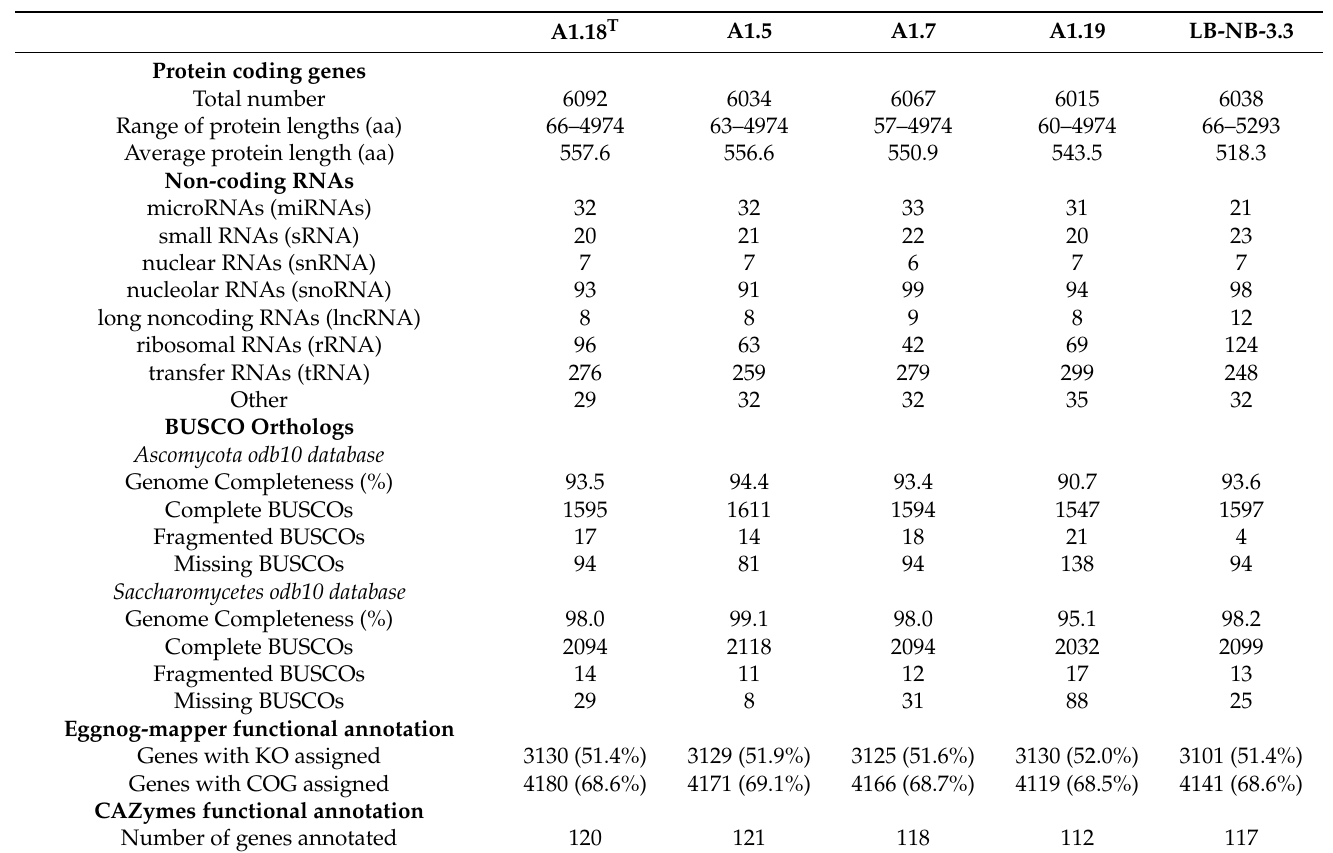
Table 2. Clavispora santaluciae genome annotation